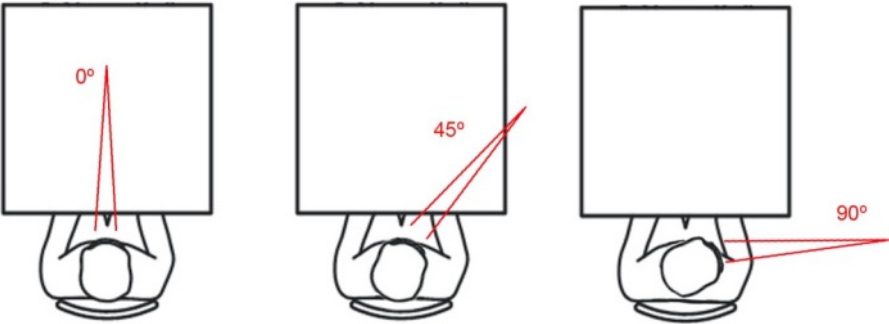
Figure 2. Eyes orientation at a height of 130 cm. On the left, the subject is looking straight at the blackboard and it is considered 0°; in the middle, the subject is turning the head 45° with respect to the blackboard and on the right looking 90° with respect to the blackboard, to the window.